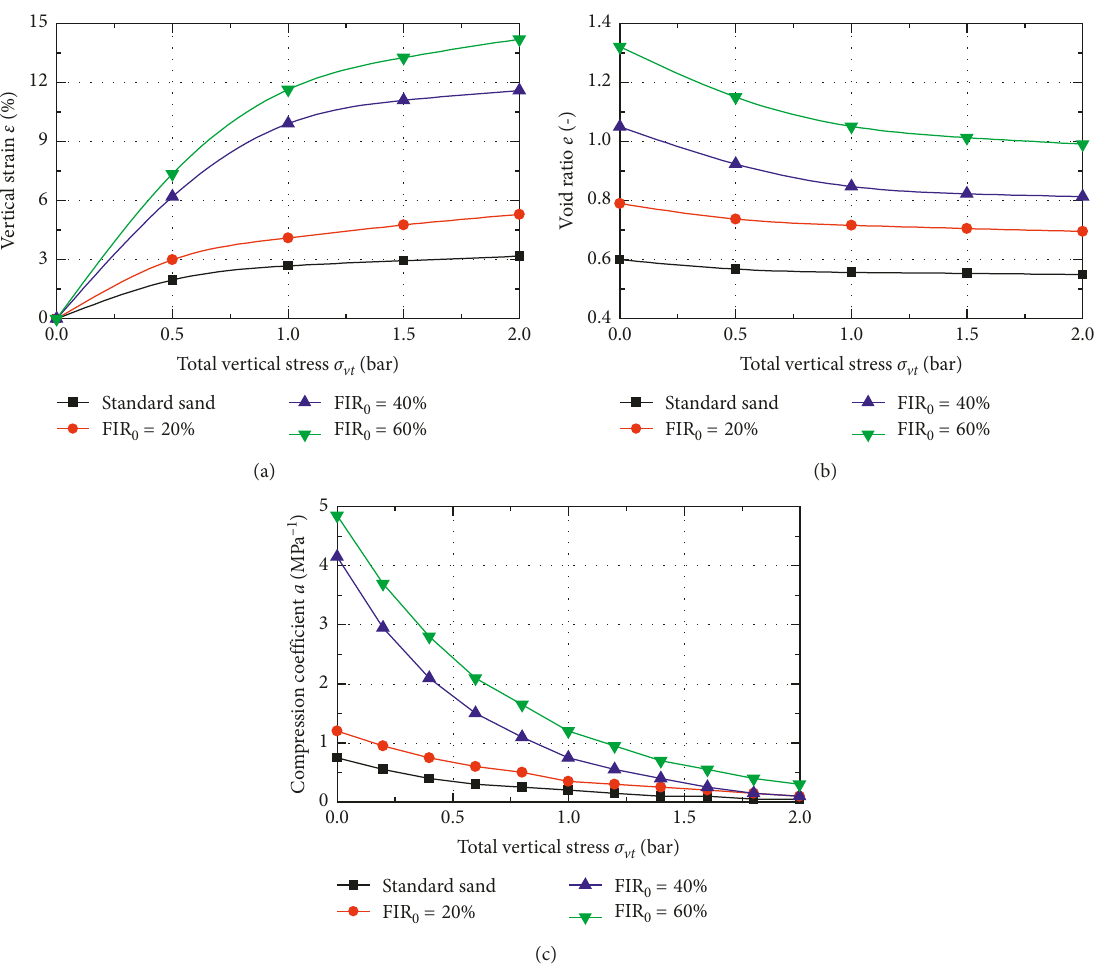
Figure 6: Compression results of foam-conditioned sand. Vertical strain ε (a), void ratio e (b), and compression coefficient a (c) plotted vs. the total vertical stress σ vt